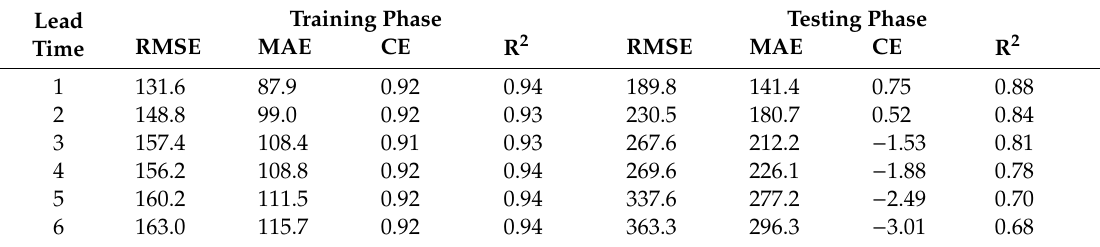
Table 8. RMSE, MAE, CE, and R 2 values of the RF model for 1- to 6-month-ahead predictions in the testing